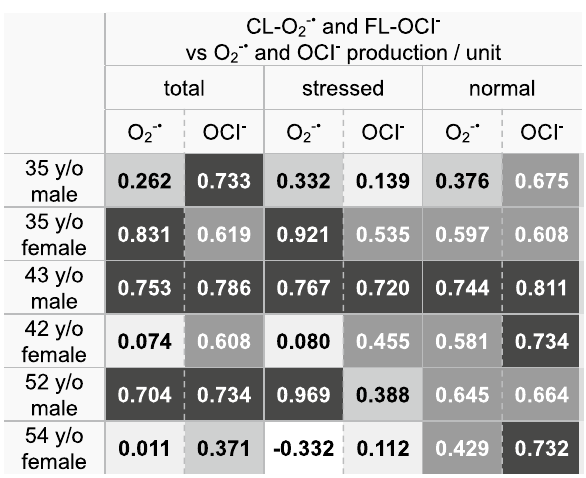
Table 4. Correlations between CL-O 2−· and the production capacities of O 2−· , and those between FL-OCl − and the production capacities of OCl − Left: Correlation coefficients of CL-O 2−· vs the O 2−· production/unit and FL-OCl − vs the OCl − production/unit in the total data range. Middle: Correlation coefficients of CL-O 2 −· vs the O 2 −· production/unit and FL-OCl − vs the OCl − production/unit in the data range with stressed conditions. Right: Correlation coefficients of CL-O 2 −· vs the O 2 −· production/unit and FL-OCl − vs the OCl − production/unit in the normal data